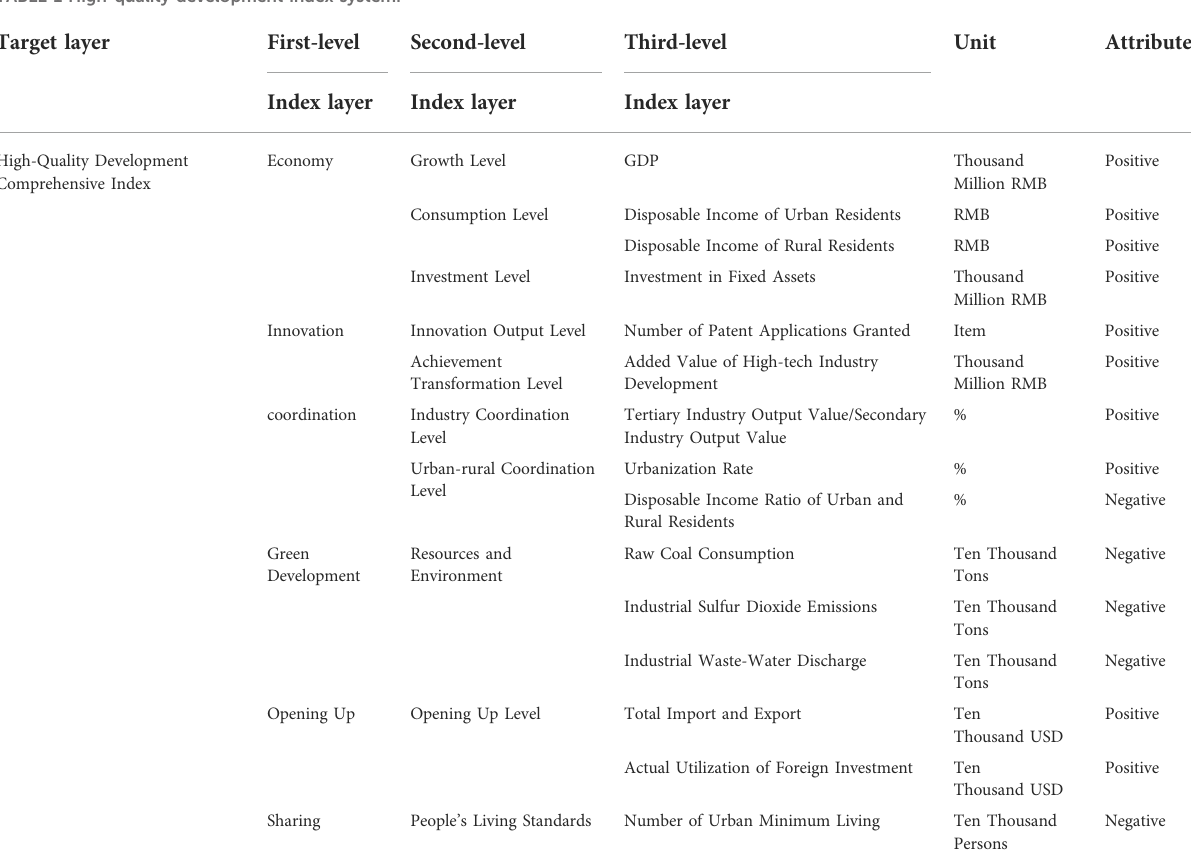
TABLE 1 High-quality development index